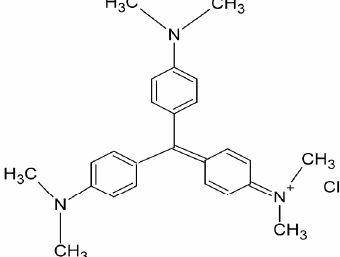
Figure 1 . Structure of crystal